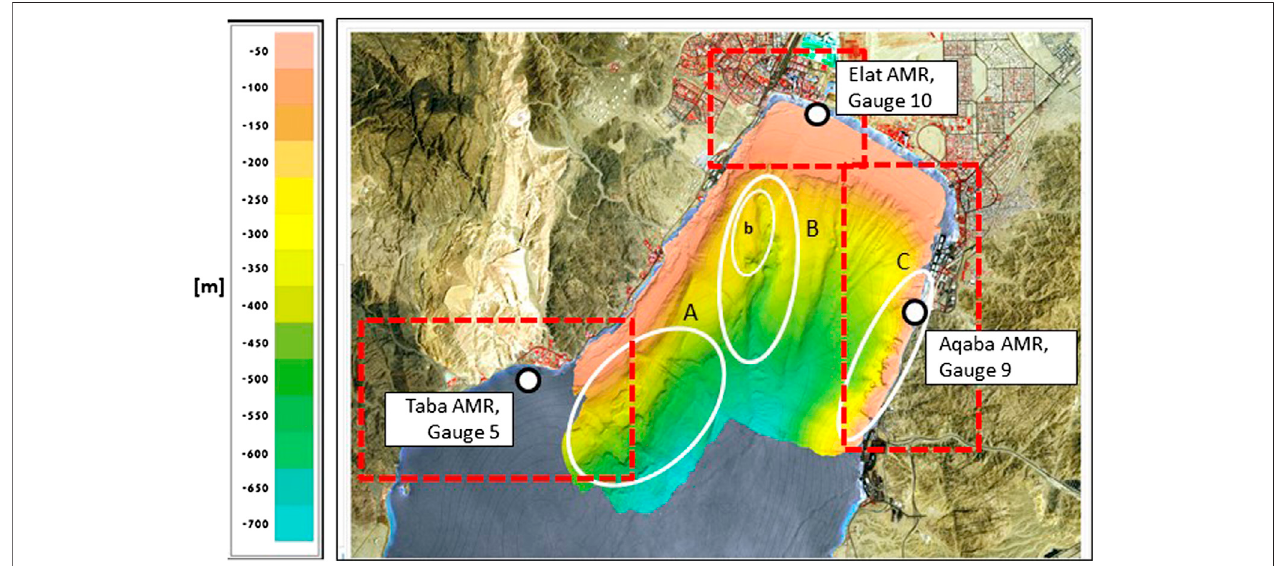
FIGURE 3 | Zones of past submarine slope failure projected on the multibeam bathymetric map of the head of the Gulf of Elat – Aqaba (HGEA) (after Sade et al., 2008). Note the three zones of submarine slope failure — (A) – (C) — and the potential area of the largest slide — b. Note also the location of the three arti fi cial tide gauges used to record the waveforms presented in Figure 5 . See Figure 1 for the location of this